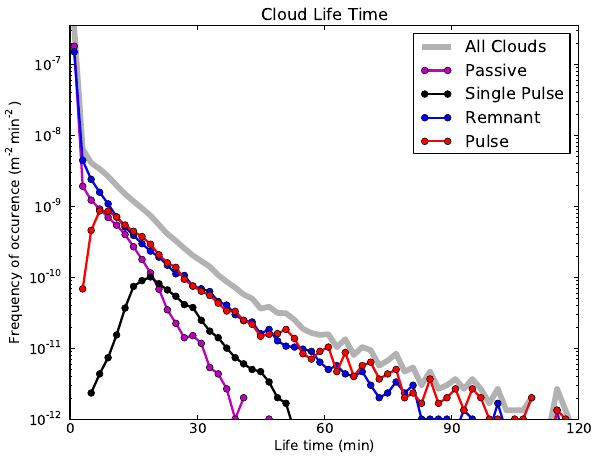
Fig. 11. Histogram of the minimum base height for all clouds, and for the different cloud types.